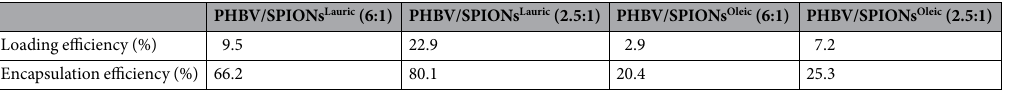
Table 1. Loading and encapsulation efficiencies of PHBV/SPIONs Lauric and PHBV/SPIONs Oleic at different mass